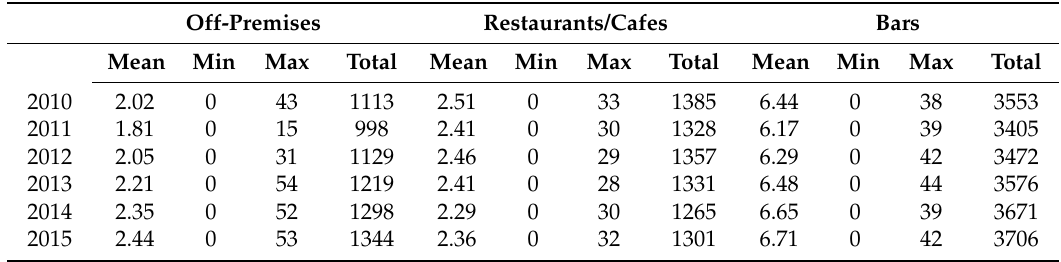
Table 1. Descriptive statistics of alcohol outlets during the six-year period of the study. Off-Premises